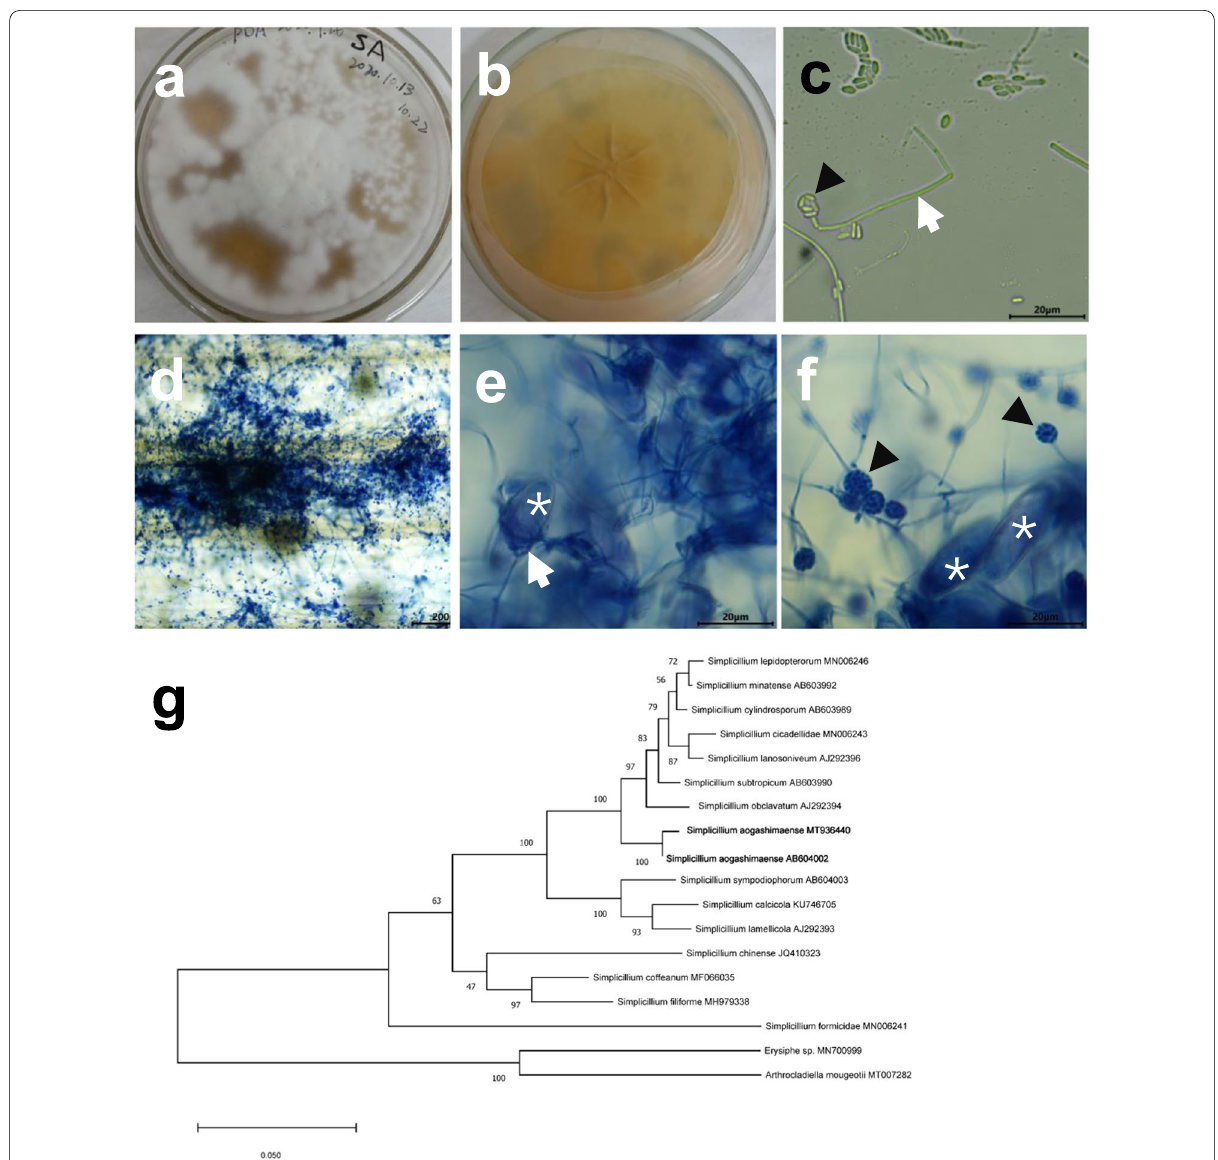
Fig. 2 Morphological characteristics and phylogenetical analysis of Simplicillium aogashimaense . a , b S. aogashimaense colonies on potato dextrose agar (PDA) at 9 dpi. c Mycelia and conidia of S. aogashimaense . d – f The interaction between S. aogashimaense and Blumeria graminis f. sp. tritici ( Bgt ) on wheat leaves. White and black arrows indicate mycelia and conidia (in globose head) of S. aogashimaense , respectively. White asterisks indicate conidia of Bgt . Scale bars 20 ( c , e , f ) and 200 μm ( d ). g The phylogeny tree of the identified S. aogashimaense (MT936440) in this study and related = Simplicillium species. The tree was constructed using the maximum likelihood method with MEGA software, with the options of 1000 bootstrap replicates, Tamura‑Nei model and 50% site coverage cut‑off. The S. aogashimaense (MT936440 and AB604002) strains are highlighted in bold. The bar indicates a distance of